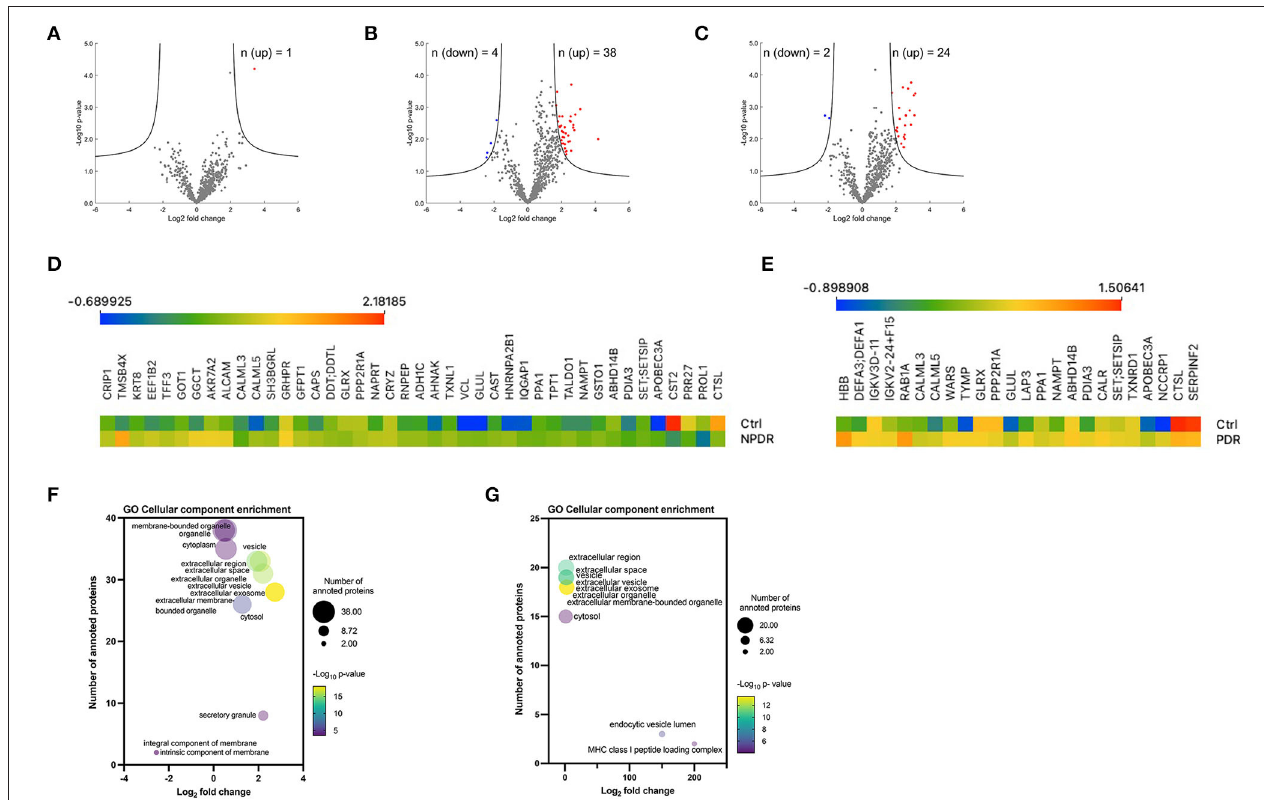
FIGURE 3 | Overview of significantly regulated proteins in diabetic subgroups compared to control group. (A–C) Volcano plots of proteomic data. Volcano plots were generated in the software Perseus, comparing the differential protein expression in tear fluid between nondiabetic healthy controls and (A) T2D group, (B) T2D with NPDDR, and (C) T2D with PDR. The points indicate different proteins that display magnitude fold-changes (Log 2 ; x-axis) and the p -values (–Log 10 ; y axis) of all proteins quantified in control group and each one of the other groups (two-sample t -test; FDR = 0.05, S0 = 1). Proteins with significant increases are indicated by red circles. Proteins with significant decreases are depicted by blue circles. (D,E) Heatmaps of the differentially expressed proteins. Protein expression values were log 2 normalized. Data corresponding to the proteins differentially expressed when comparing (D) NPDR and (E) PDR with the controls. Red indicates a high expression level; blue indicates a low expression level. (F,G) Bubble plots showing the enrichment for GO cellular component terms for the significantly expressed proteins in NPDR and PDR groups. The log 2 (fold change) in x-axis represents the ratio of total proteins identified and the different proteins expected to be related to each cellular component; the size of the bubble represents the number of proteins for each cellular component and color represents the –log 10 ( p -value), which indicates the statistical significancy. No statistically significant enrichment was found in biological process (not